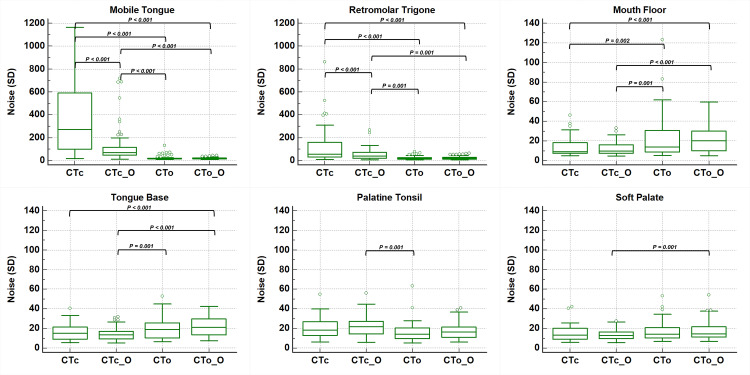
Box-and-whisker plots of the quantified noise level according to the anatomical structures and Computed Tomography (CT) protocols.The bottom and top of box are the first and third quartiles, the horizontal line represents the median value, and the vertical line represents the difference between the maximum and minimum values. Statistically significant differences with P values less than 0.008 are presented in the figure. CTc = conventional CT; CTc_O = conventional CT with O-MAR processing; CTo = open mouth CT; CTo_O = open mouth CT with O-MAR processing; O-MAR = metal artifact reduction for orthopedic implants.